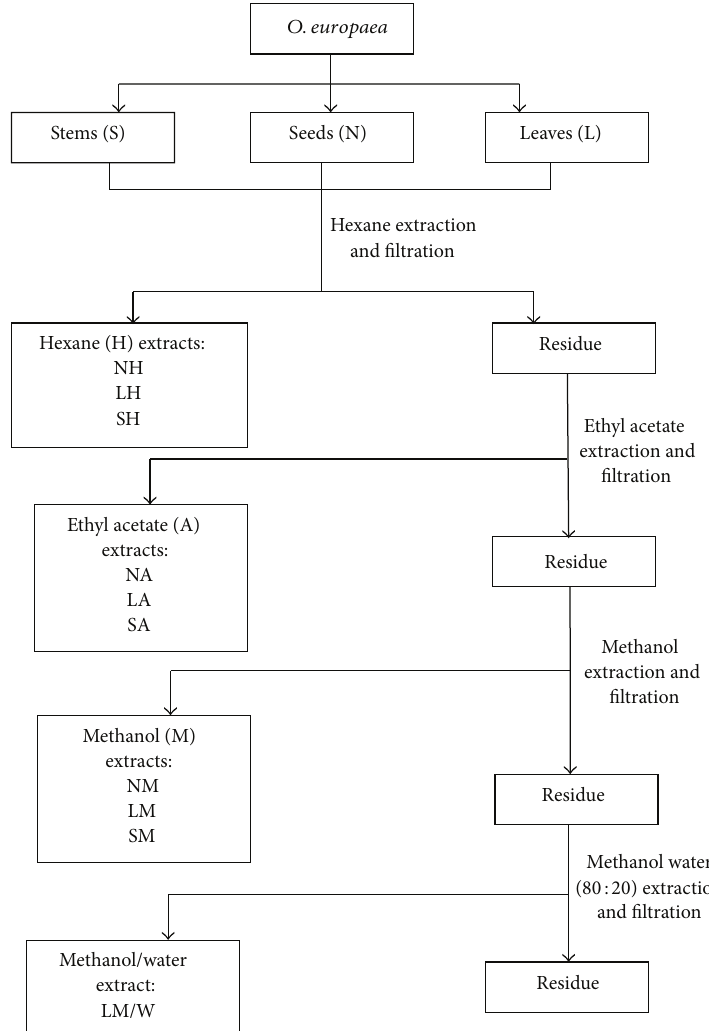
Figure 1: General scheme of extraction